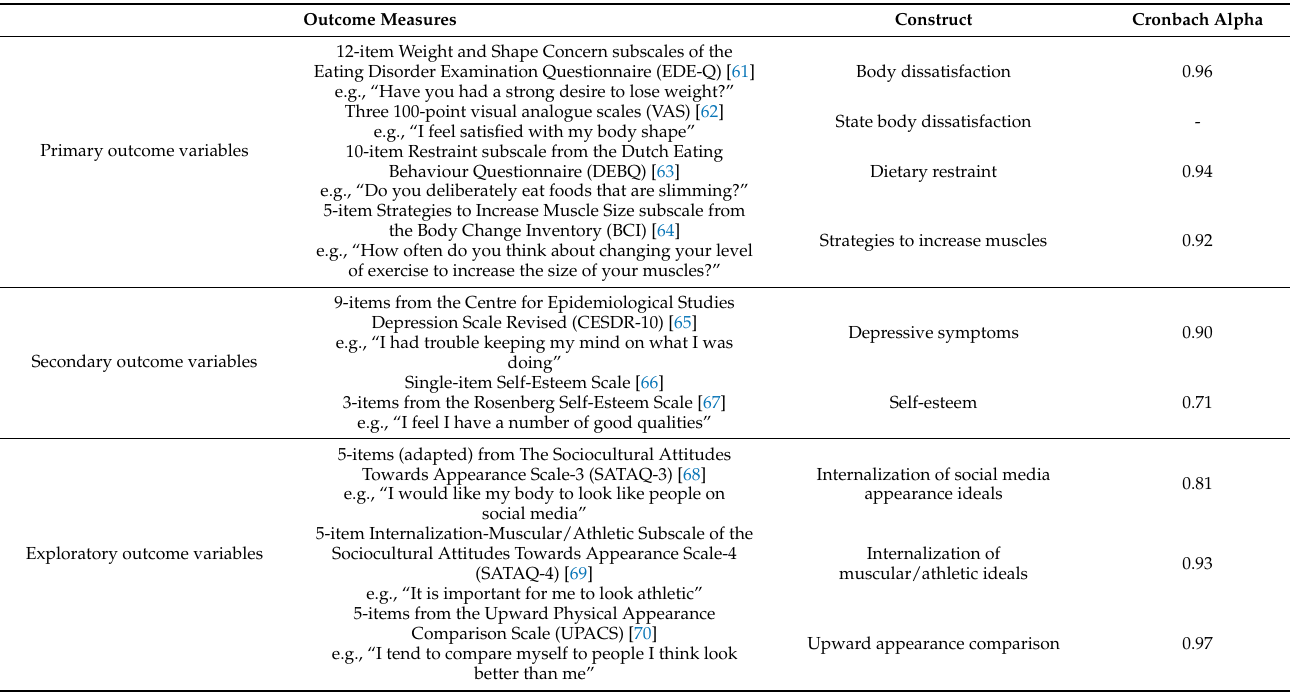
Table 1. Overview of the instruments used to evaluate the efficacy of the SoMe intervention. Outcome Measures